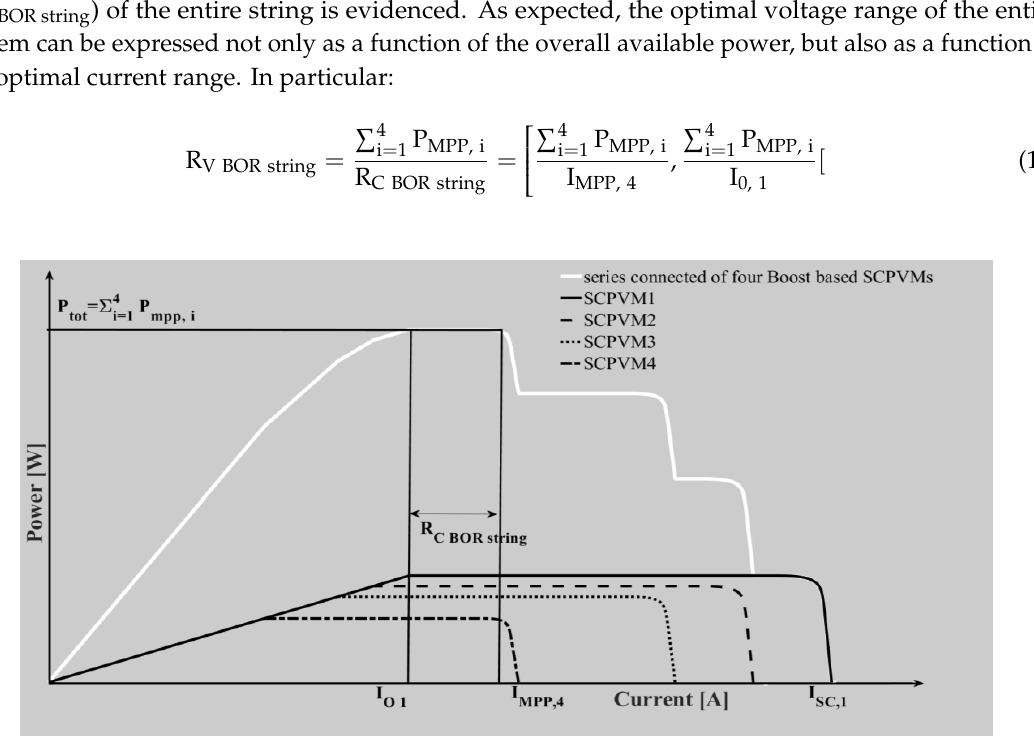
Figure 8. P-I characteristic of the series connection of four Figure 8 . P-I characteristic of the series connection of four SCPVMs.